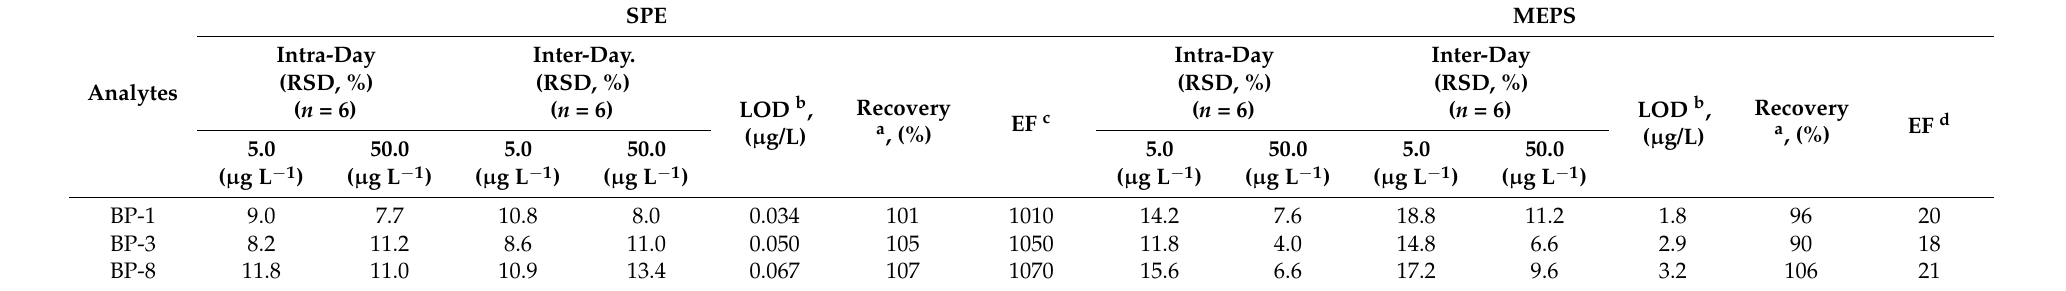
Table 1. Characteristics of the SPE-GC-MS and MEPS-GC-MS methods for the determination of BPs in water